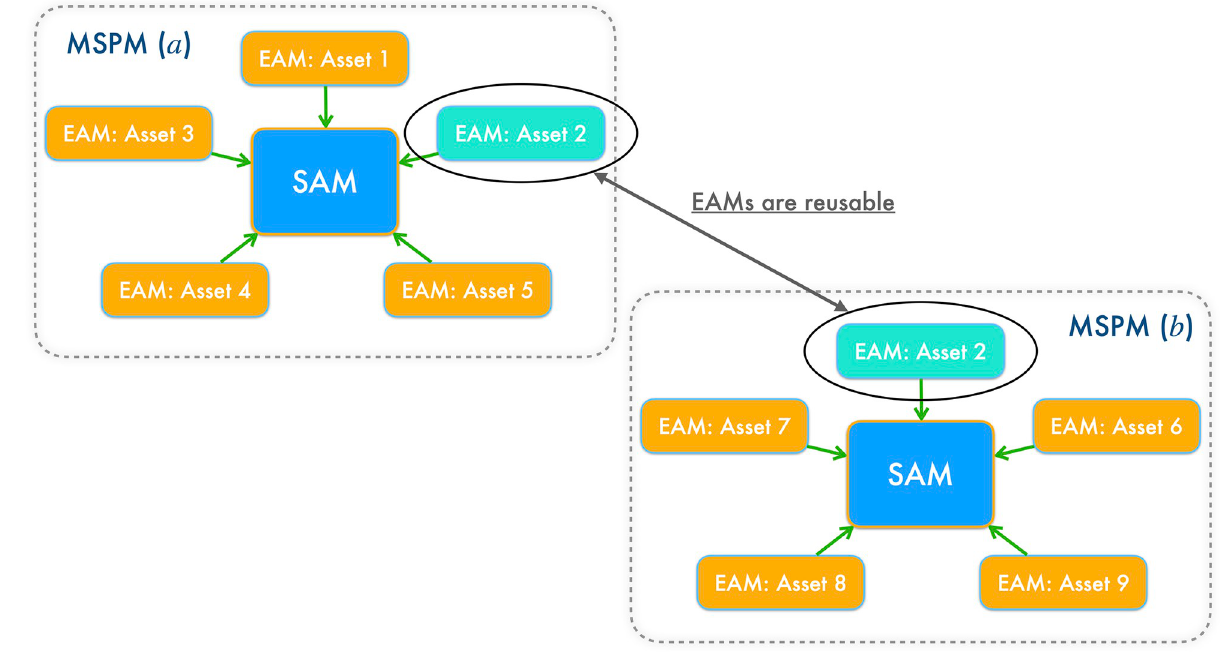
Fig 2. A more intuitive illustration of MSPM’s architecture. EAMs are reusable for different portfolios. EAMs can be combined and connected to any SAMs at will, like assembling LEGO blocks.